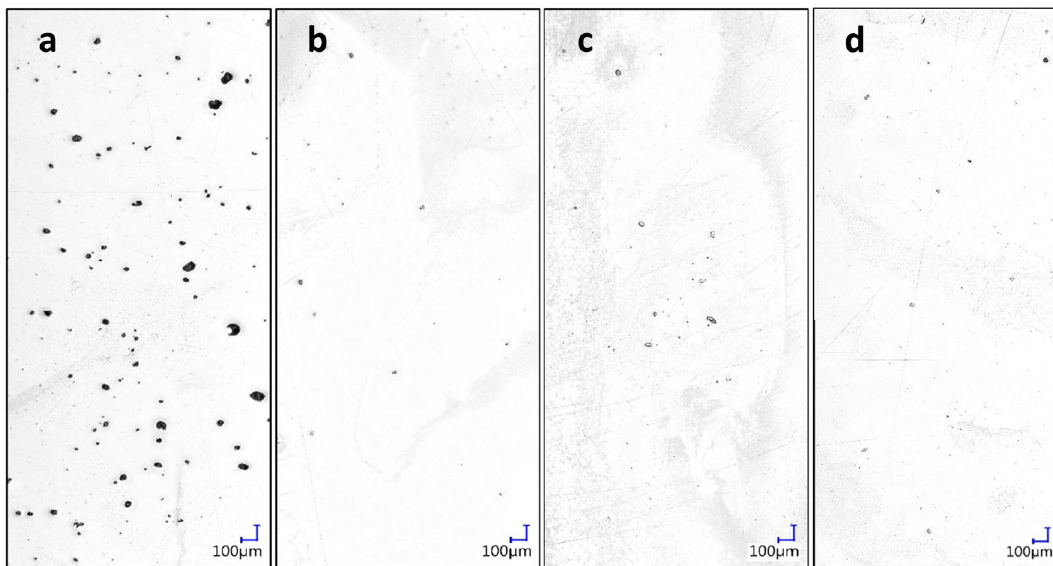
Figure 2. Micrographs of selected cross-sections showing pore density resulting from different printing speeds. Laser scanning speed of (a) 750 mm/s (porosity area ratio (PAR): 1.29%, average size ( D ) : 26.1 µm), (b) 1250 mm/s (PAR: 0.05%, D : 12.1 µm), (c) 1750 mm/s (PAR: 0.14%%, D : 12.6 µm) and (d) 2000 mm/s (PAR: 0.37%%, D : 9.3